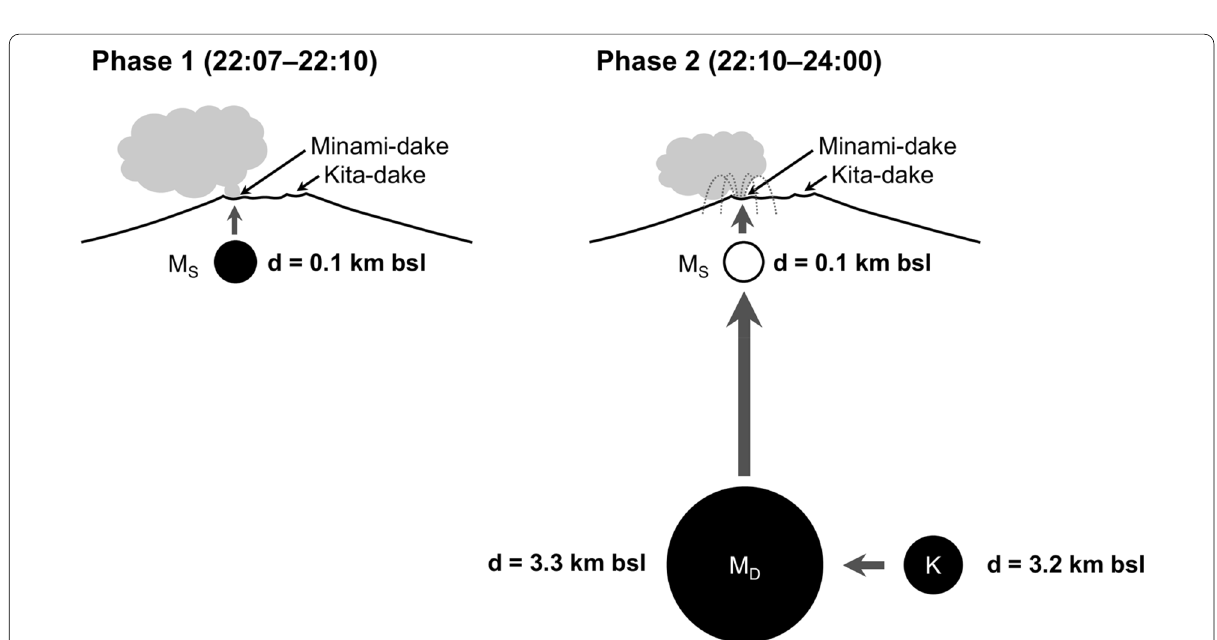
Fig. 9 Schematic diagrams of magma migration during the Minami-dake explosion revealed in the present study. The left diagram represents phase 1 (22:07–22:10) and the right represents phase 2 (22:10–24:00). The open and solid circles represent inflation and deflation of the spherical sources, respectively. The thickness of the arrows between each source or the Minami-dake crater represents the amount of magma migration based on the assumption that uncompressible magma migrates from sources K to M D , M D to M S , and M S to Minami-dake crater, and magma is not injected towards source